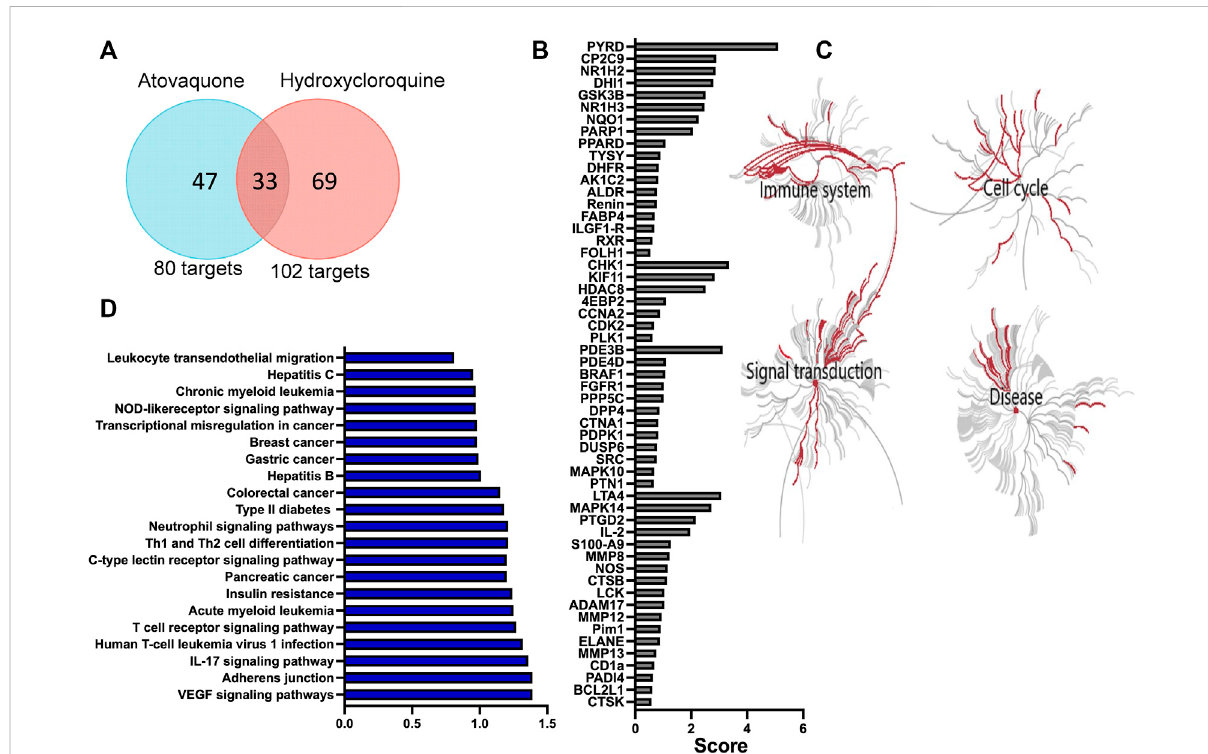
FIGURE 1 Atovaquone is predicted to have unique biological targets and functions in disease. (A) Comparison of atovaquone and hydroxychloroquine predicted targets using PharmMapper. (B) Top predicted targets of atovaquone according to PharmMapper. (C) GO analysis predicted biological functions targeted by atovaquone. (D) KEGG analysis identi fi cation of disorders associated with atovaquone